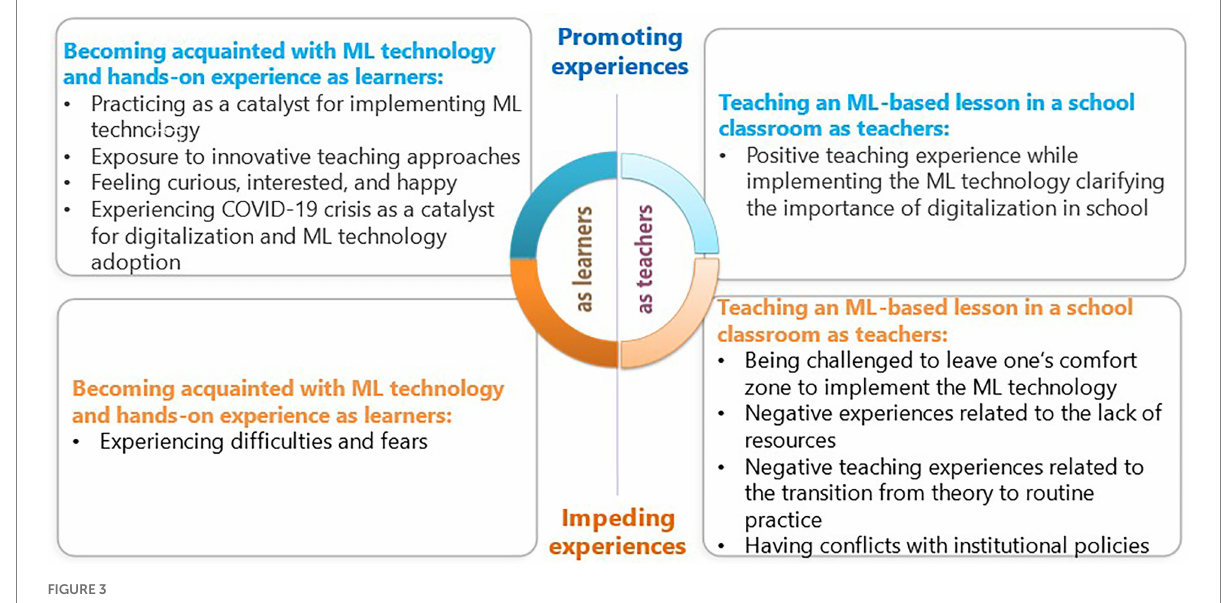
FIGURE 3 Experiences promoting vs. impeding ML